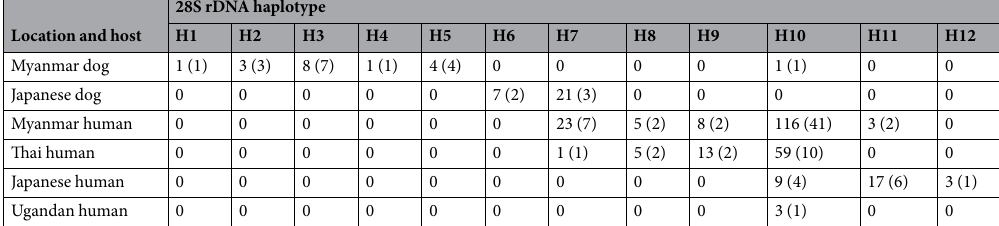
show any noticeable difference to the reported morphologies for this species, we conducted a morphometrics analysis using free-living male and female adult worms (Table 6). The worms were picked from an additional agar culture plate with fecal sample of a Myanmar dog. In case of free-living female adults (n = 17), the parameters measured (body length, body width, esophagus length, and mouth-to-vulva length) were almost identical to those reported by Little 13 . The relative length of eso- phagus to the total body length was more similar to S . stercoralis than to S . procyonis . As for the free-living male adults (n = 17), they were measured to be larger (9.0% longer and 7.0% wider) than the reported values for S . ster- coralis on average. When values for the individual worms were looked at, they were within the ranges of reported values in most cases (15 out of 17 and 16 out of 17 worms for body length and body width measurements, respec- tively [data not shown]). The body length/width ratio, relative esophagus length, and absolute spicule length were nearly or completely identical to the reported values for S . stercoralis .